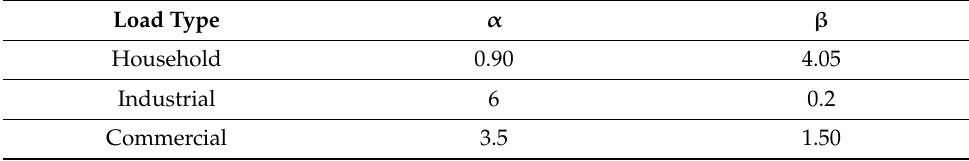
Table 1. Type of load and power values for modeling.